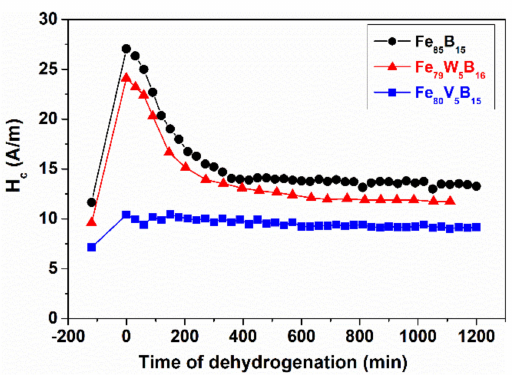
Figure 35. Change of coercivity ( H c ) during hydrogen desorption in Fe 85 B 15 , FeW 5 B 15 and FeV 5 B 15 samples. Adopted from [121], with the permission from AIP Publishing LLC, 2005.